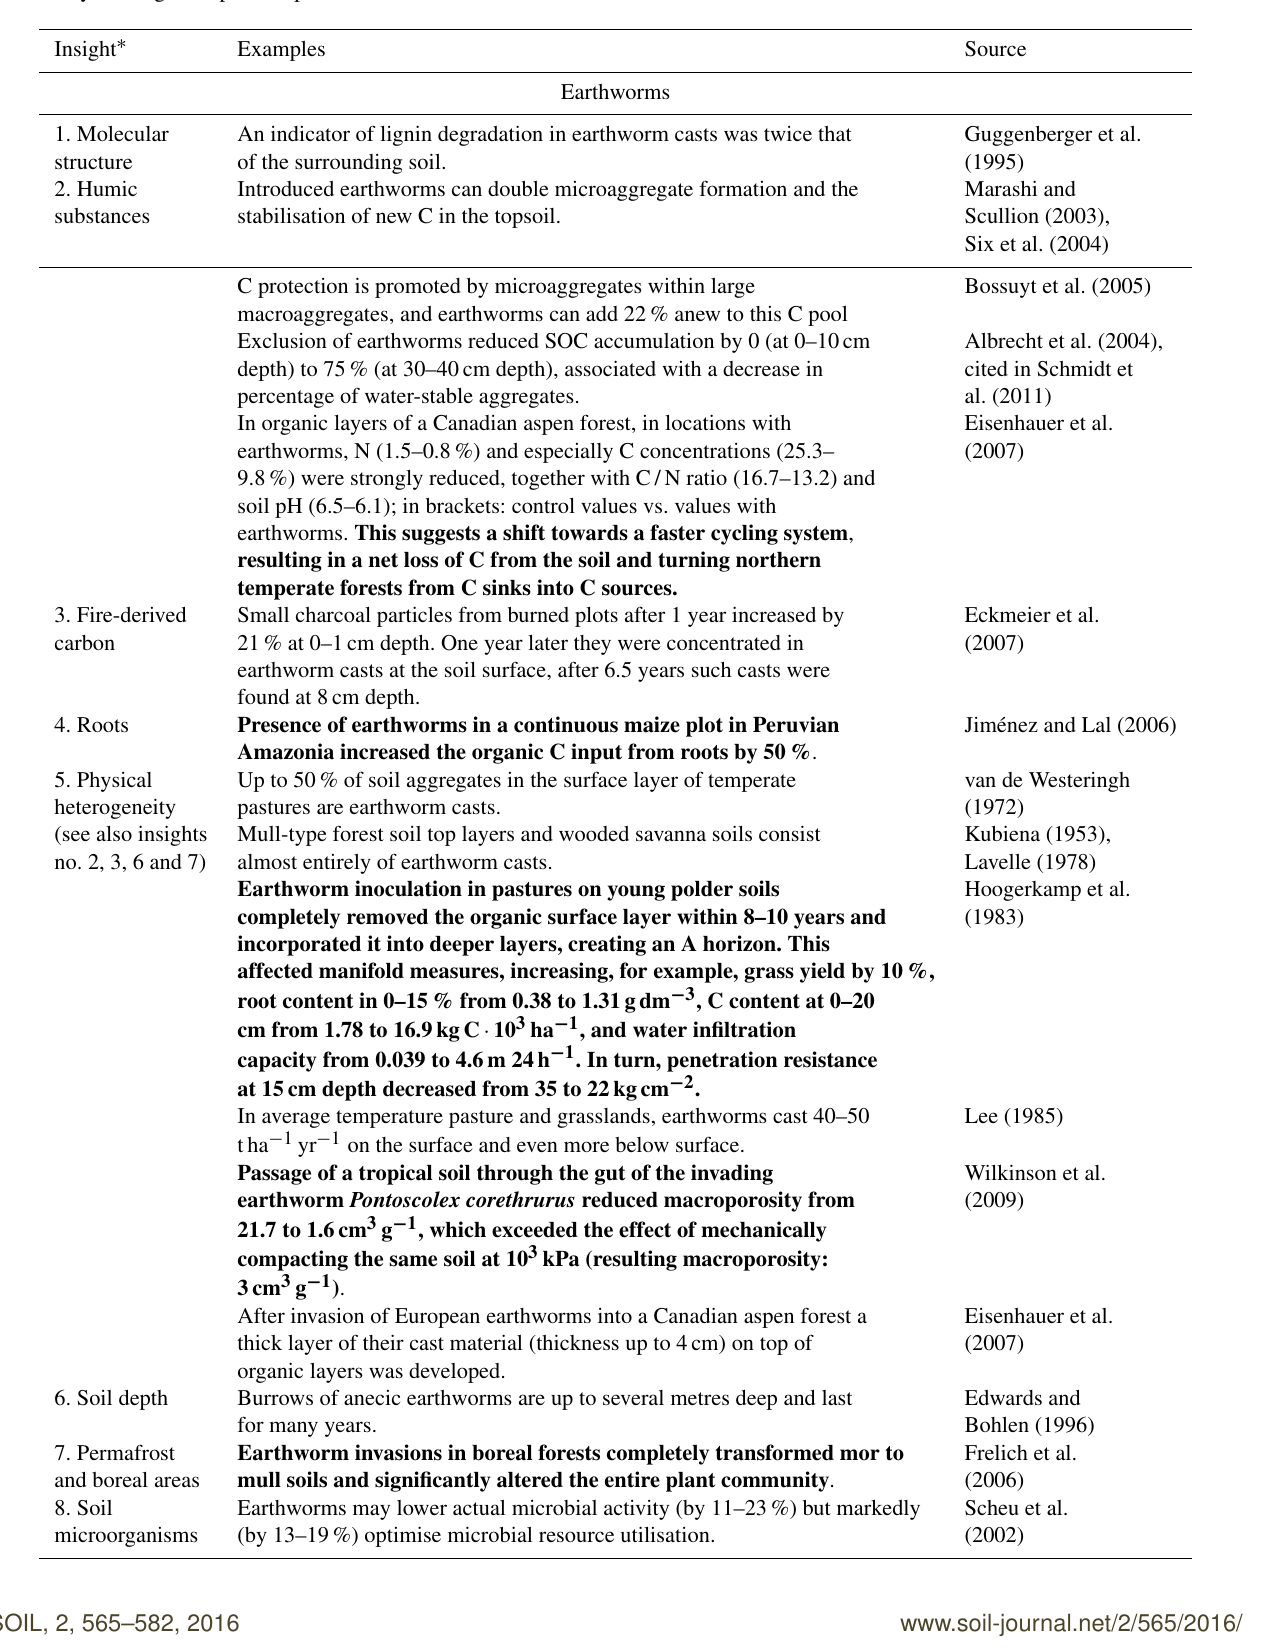
Table 1. Quantitative examples of the impact of earthworms and selected groups of other soil fauna on soil properties and processes involved in soil organic matter (SOM) turnover. If not mentioned otherwise, any numbers or percentages refer to the control without fauna. Selected, particularly striking examples are printed in